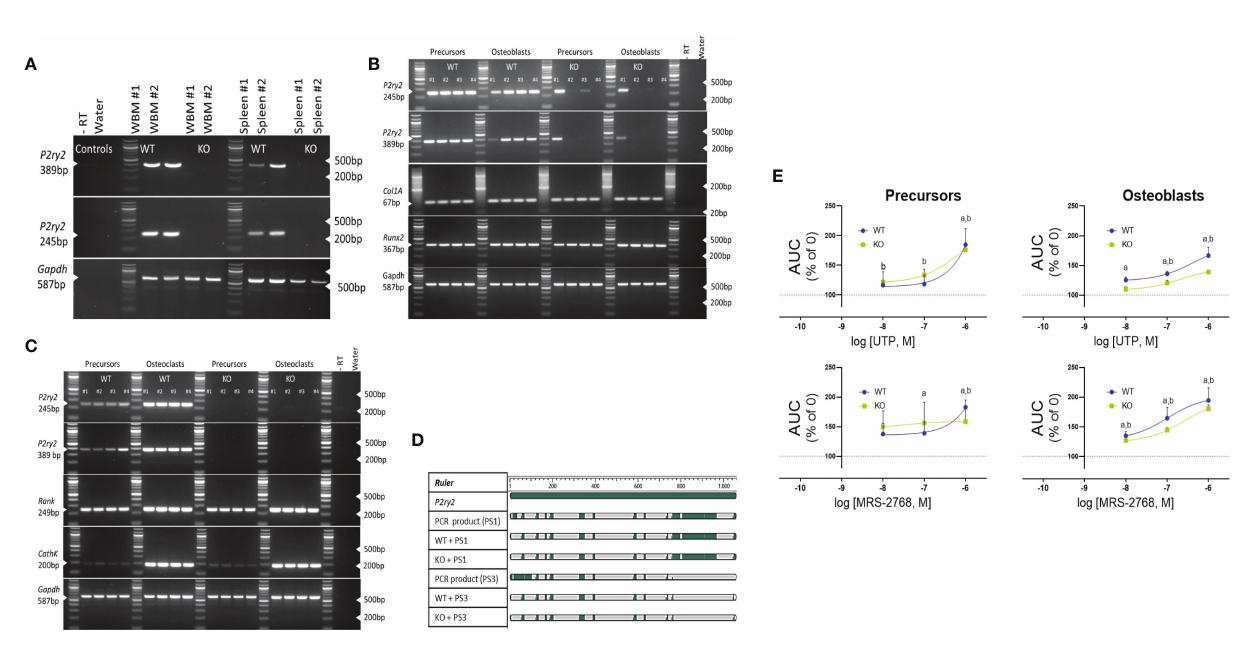
FIGURE 5 | Expression of the P2Y 2 receptor in (A) whole bone marrow (WBM) and spleen, (B) osteoblast precursors and osteoblasts and, (C) osteoclast precursors and osteoclasts. cDNA was reverse transcribed after tissue lysis and probed using the 2 different primer sets designed between 552 bp – 1149 bp of the P2ry2 gene transcript (corresponding to the region of the targeting vector used to create the gene knock out). Products of 389 bp (corresponding to 676 bp -1065 bp) and 245 bp (corresponding to 612 bp to 857 bp) were ampli fi ed in osteoblast precursors and osteoblasts of KO mice. Col1A and Runx2 were used as positive control for osteoblast- lineage and -differentiation, RANK and CathK were used as positive control for osteoclast-differentiation and GAPDH was used as sample loading control. (D) Alignment of the ampli fi ed PCR products (389 bp product = PS1 and 245 bp product = PS3) indicates matched regions (green) between the transcript from KO cells, WT cells and the P2ry2 receptor gene sequence. (E) Intracellular release of [Ca 2+ ] i expressed as area under the curve (AUC) with increasing doses (10 -8 - 10 -6 M) of UTP (a potent agonist at the P2Y 2 receptor) and MRS-2768 (a selective P2Y 2 receptor agonist with no af fi nity for human P2Y 4 or P2Y 6 receptors) shows a functional response in the osteoblast precursors and osteoblasts from WT and KO mice. Statistical signi fi cance was tested with one-way ANOVA from no agonist control using (a, P < 0.05 in WT and b, P < 0.05 in KO. Data shows mean ± SEM of n = 3 repeat experiments with 3 replicates per dose of each